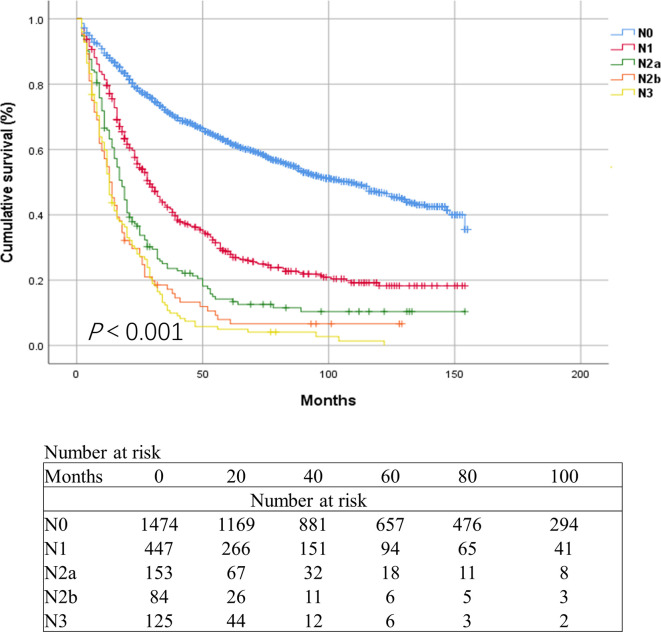
Kaplan-Meier survival curves for esophageal cancer patients of in the SEER database based on the revised N categories.